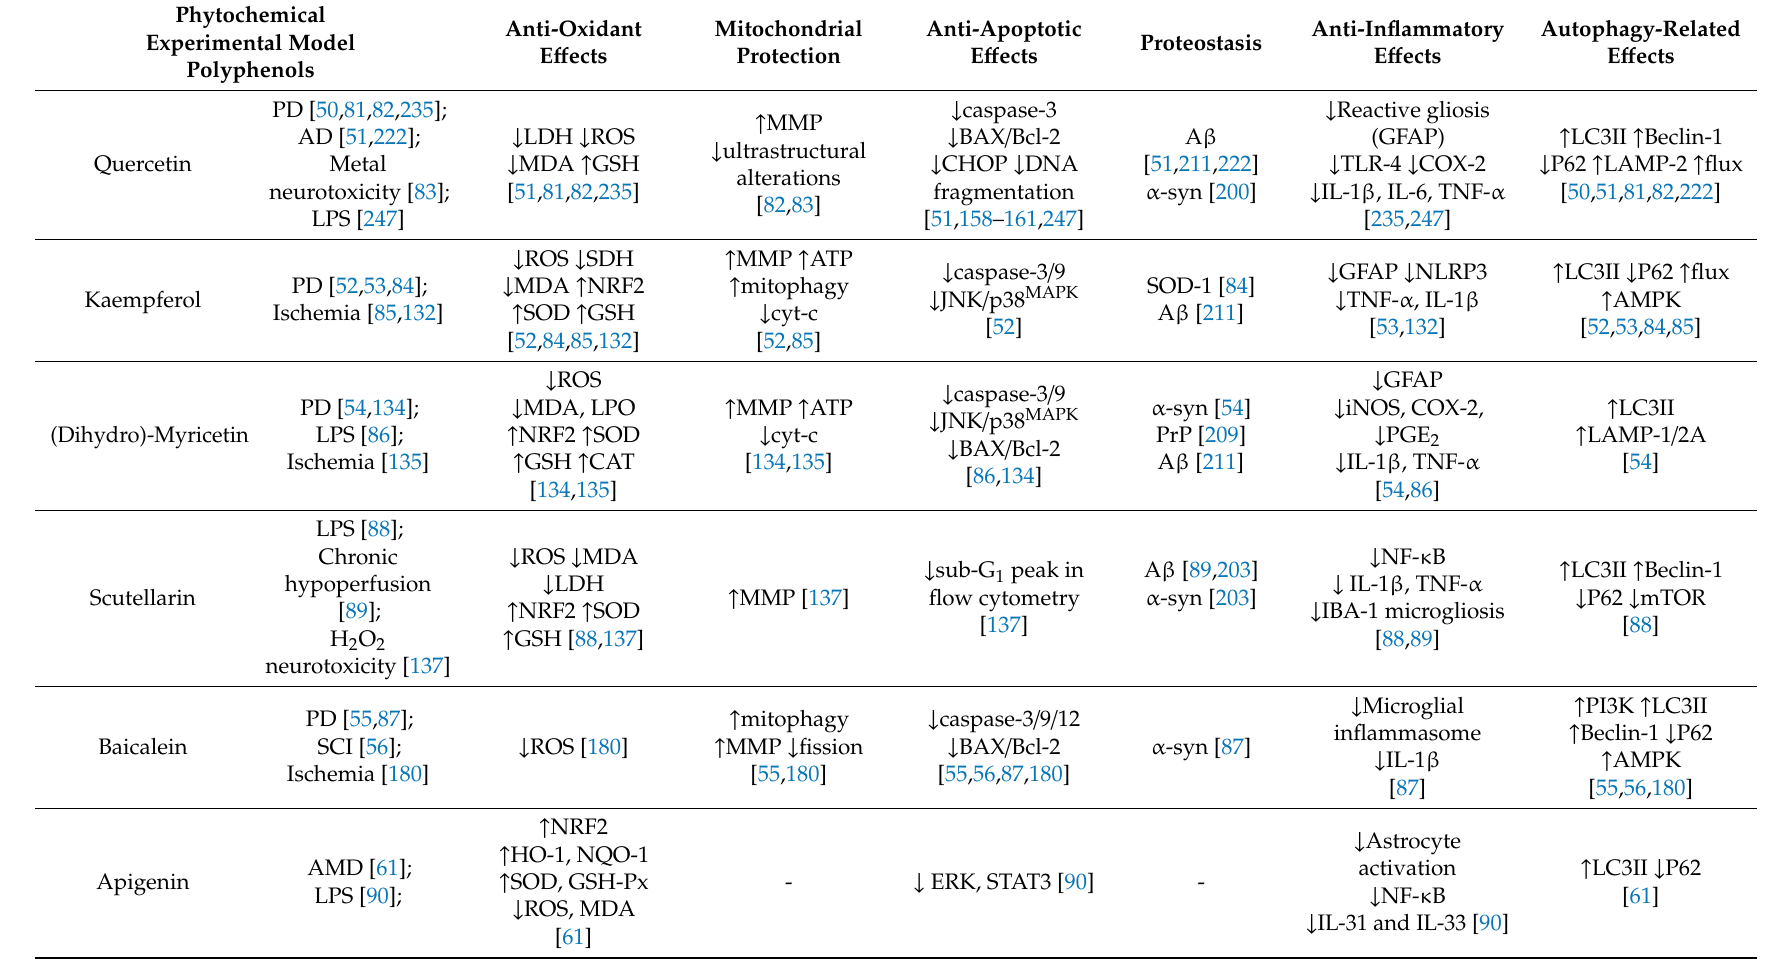
Table 2. Summary of phytochemical-targeted molecular pathways in models of neurodegeneration, neurotoxicity and